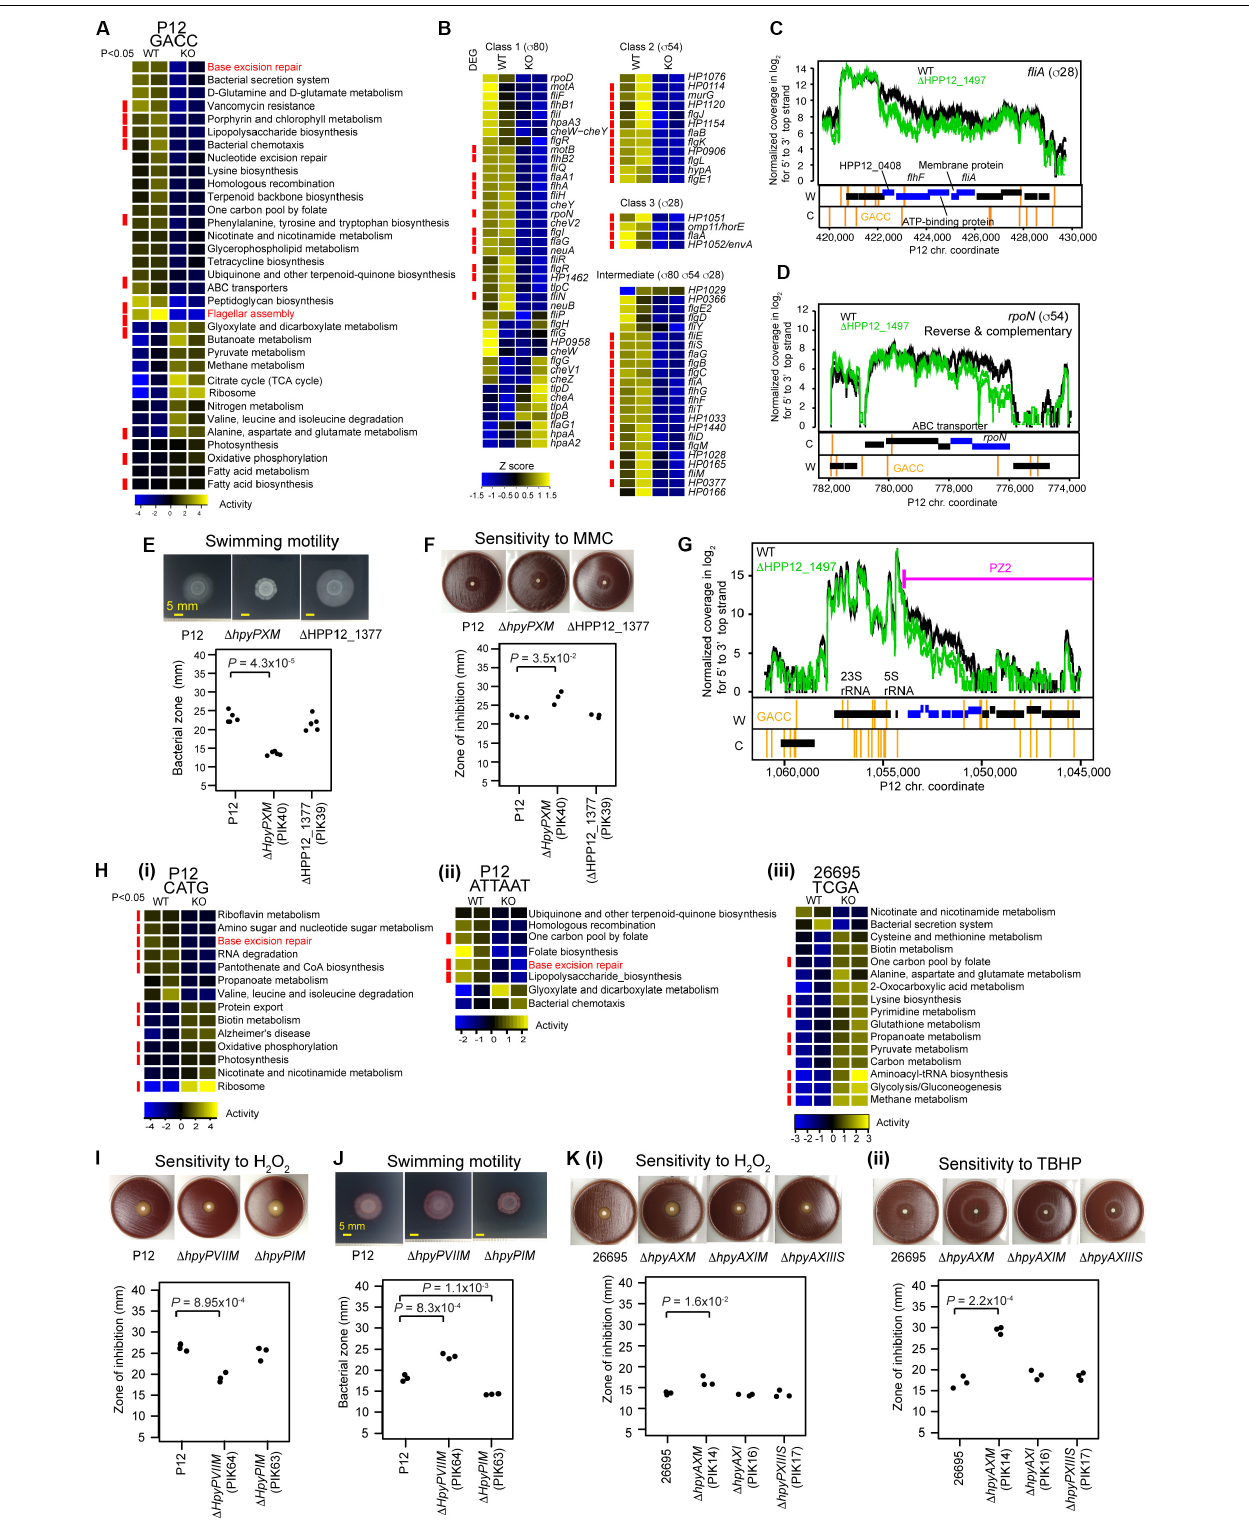
FIGURE 4 | Transcriptome and phenotype changes in methyltransferase knockouts. (A) Transcriptome changes at the pathway level in (cid:49) hpyPXM . Top 33 KEGG pathways with P < 0.1 ( n = 2) in Welch’s t -test are shown. A pathway category with P < 0.05 is indicated by a red side bar. (B) Shut down of motility regulation